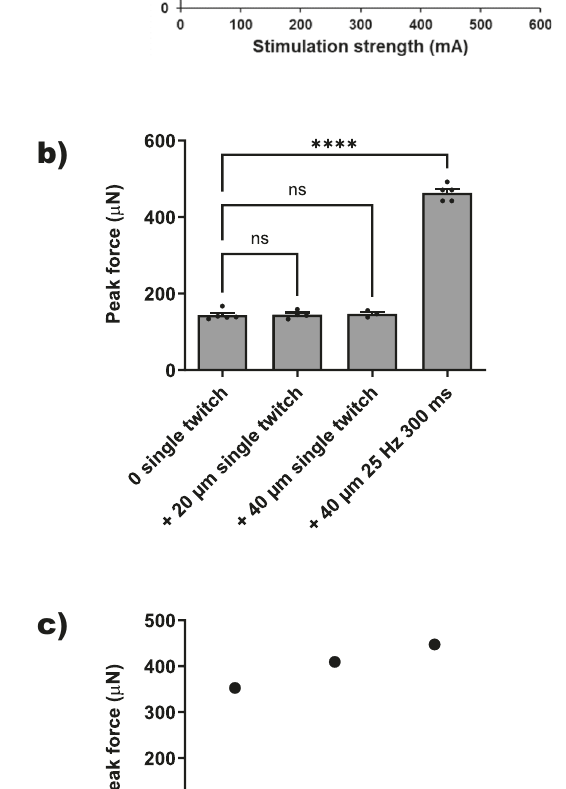
Fig. 5 Measurement of EPS-induced contractile force. a Representative 2 ms single twitch EPS-induced contractile peak forces of a 3D model from a 19-year-old donor, differentiated for 18 days, in relation to pulse strength. b Effect of model elongation and single versus multiple twitch activation on 400 mA EPS-induced contractile peak force production in a representative model ( n ≥ 3 stimulations) Shown are means ± sem. Statistics: One-way ANOVA, Bonferroni ’ s Multiple Comparison test, **** p < 0.0001. c Effect of EPS (50 Hz, 300 ms, 400 mA) pulse length on contractile peak force in a representative model. d Effect of 1 µ M TTX or solvent control (Con) on EPS- induced (1 ms pulse, 25 Hz, 300 ms, 400 mA) contractile peak force in a representative model from a 19-year-old donor differentiated for 17 days ( n = 6 stimulations). Shown are means ± sem. Statistics: Unpaired t test, **** p <